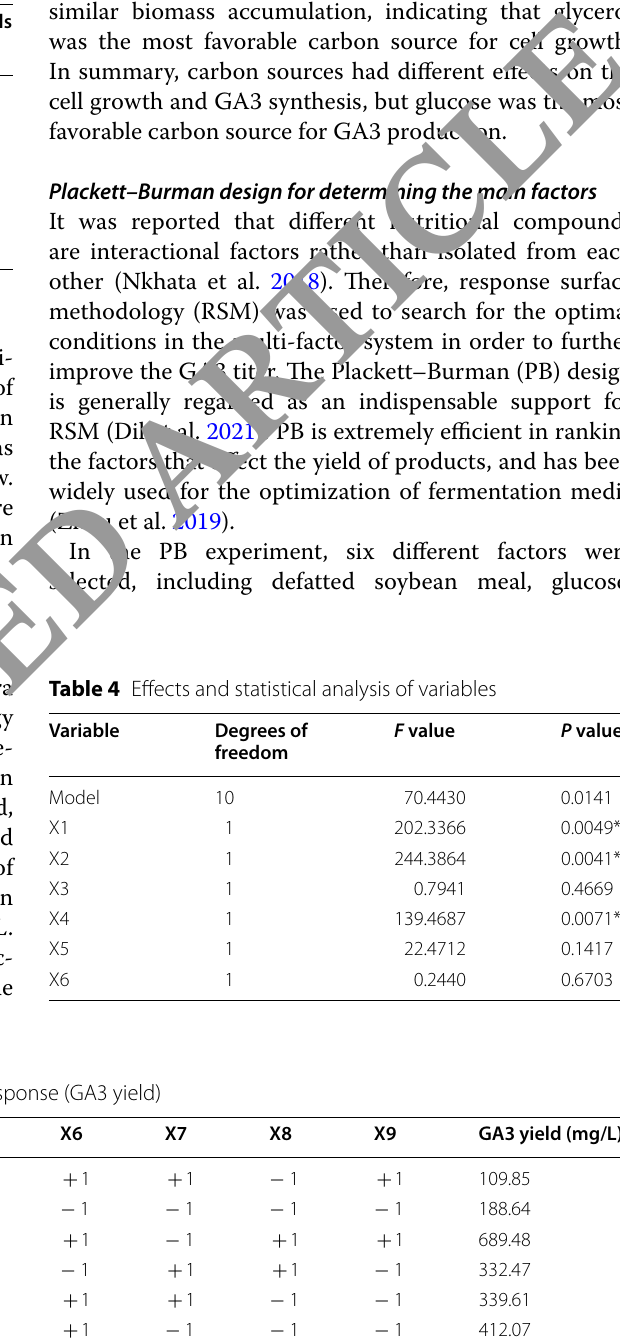
Table 2 Variables and their levels employed in the Plackett– Burman design